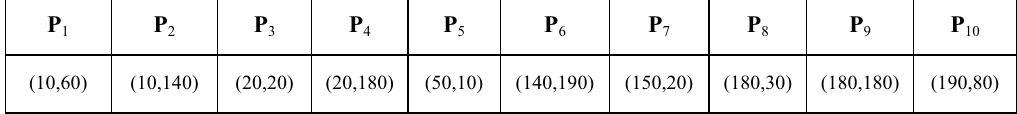
Table 7. Initial positions of robots. P i = (X i ,Y i ) is position of i th robot.